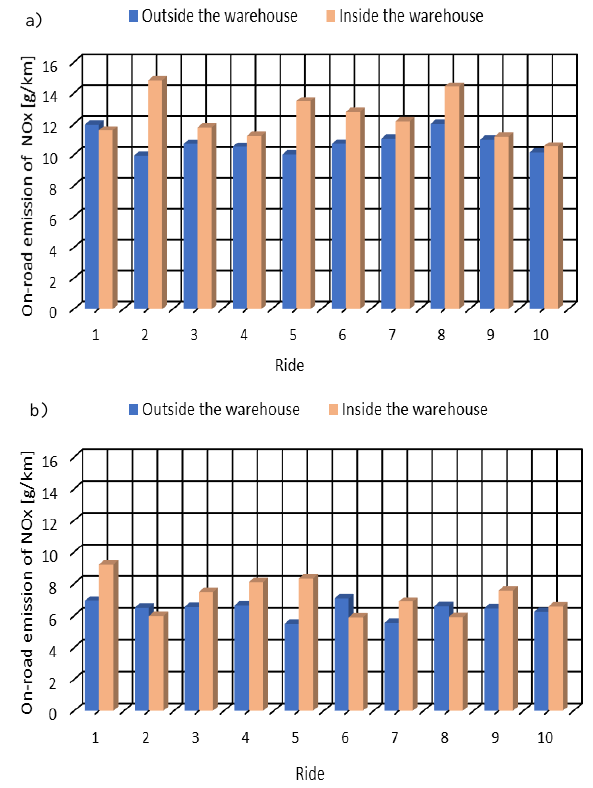
Fig. 6. On-road emissions of NO x of a forklift truck equipped with a CI engine: a) when carrying a load, b) when driving